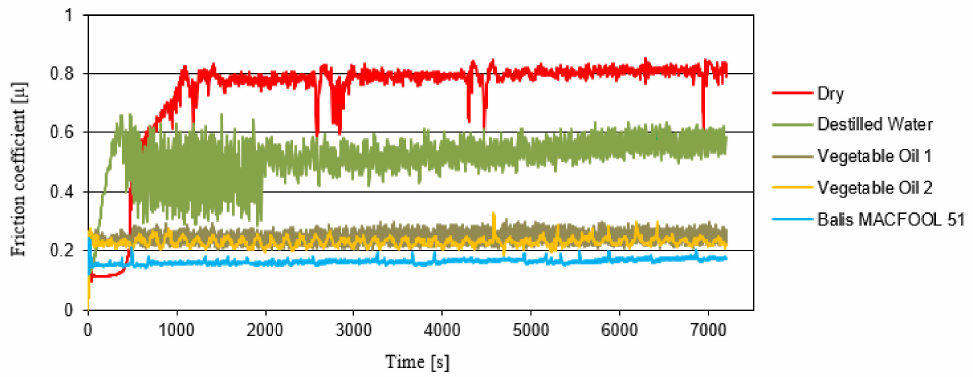
Figure 13. Comparison of the tribology tests of the evolution of the friction coefficient during sliding (alumina ball against stainless steel; W = 5 N; v = 0.5